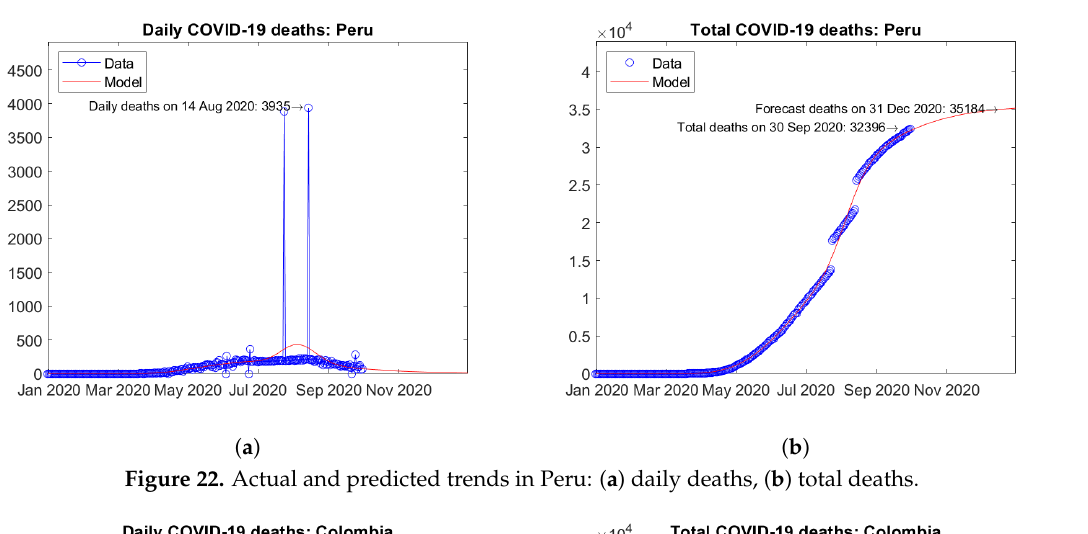
Figure 21. Actual and predicted trends in Brazil: ( a ) daily deaths, ( b ) total deaths.